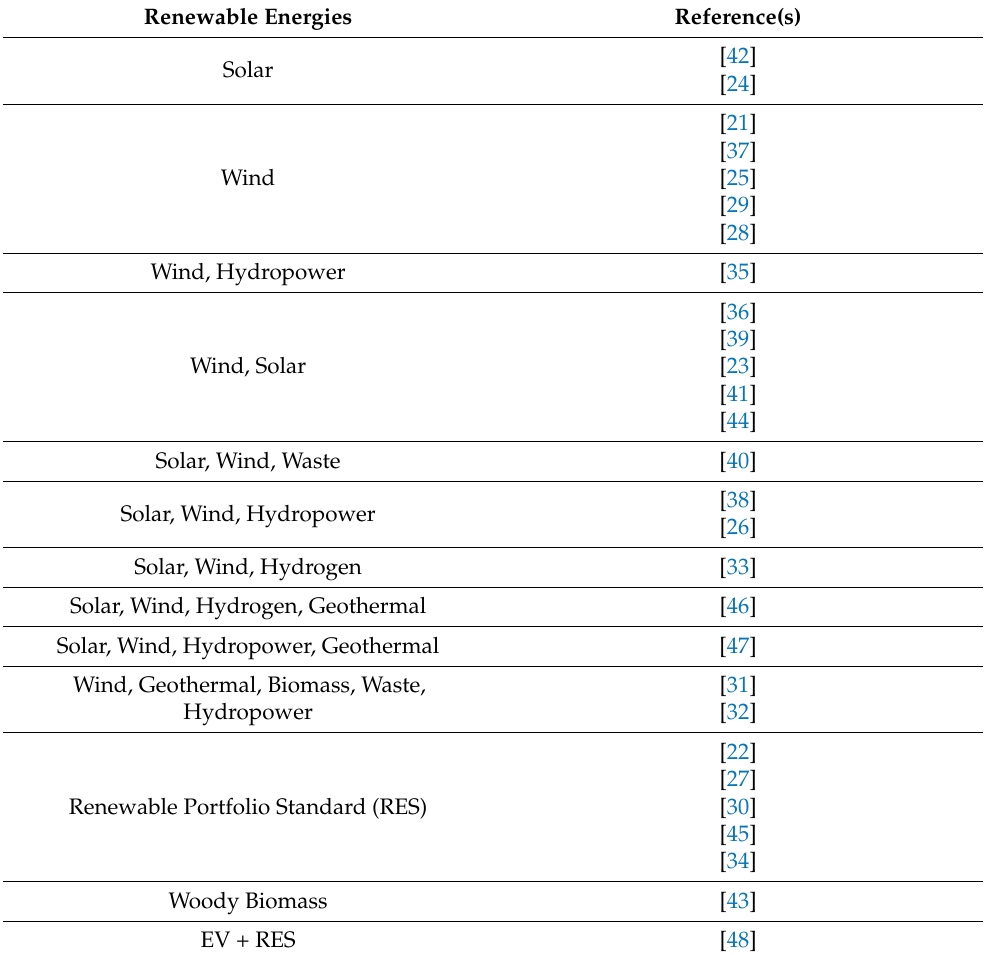
Table 6. Types of RES covered in the literature (source: own